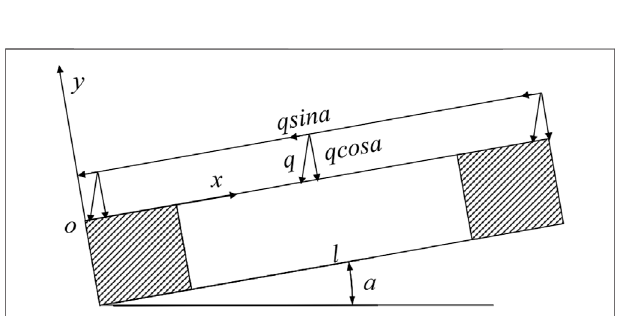
FIGURE 3 | Stress analysis of simply supported rock